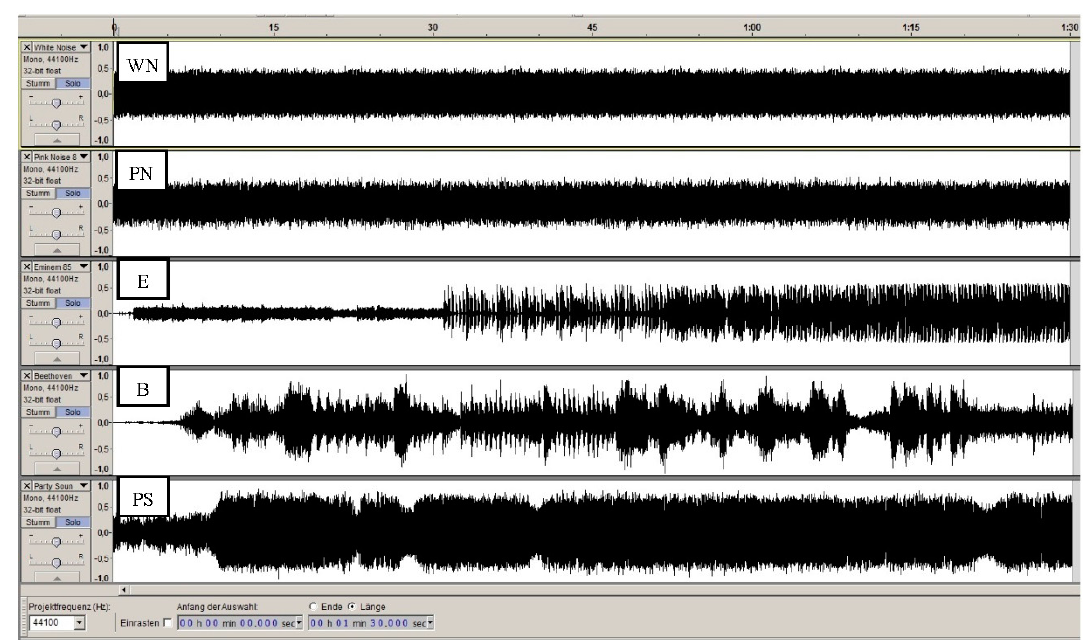
Figure 1. Time signal of white noise (WN), pink noise (PN), Eminem (E), Beethoven (B), and Party Sound (PS) with equivalent continuous sound pressure level of 85 dB and duration of 90 s. Table 2. Psychoacoustic factors of the unprocessed signals: sound pressure level ( L ), loudness level ( L N ), and specific fluctuation strength ( Fl s’) 1 .